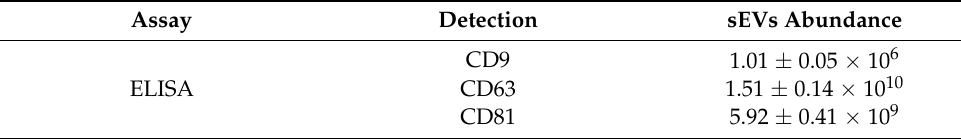
Table 1. Detection of MSCs-CM-derived sEVs